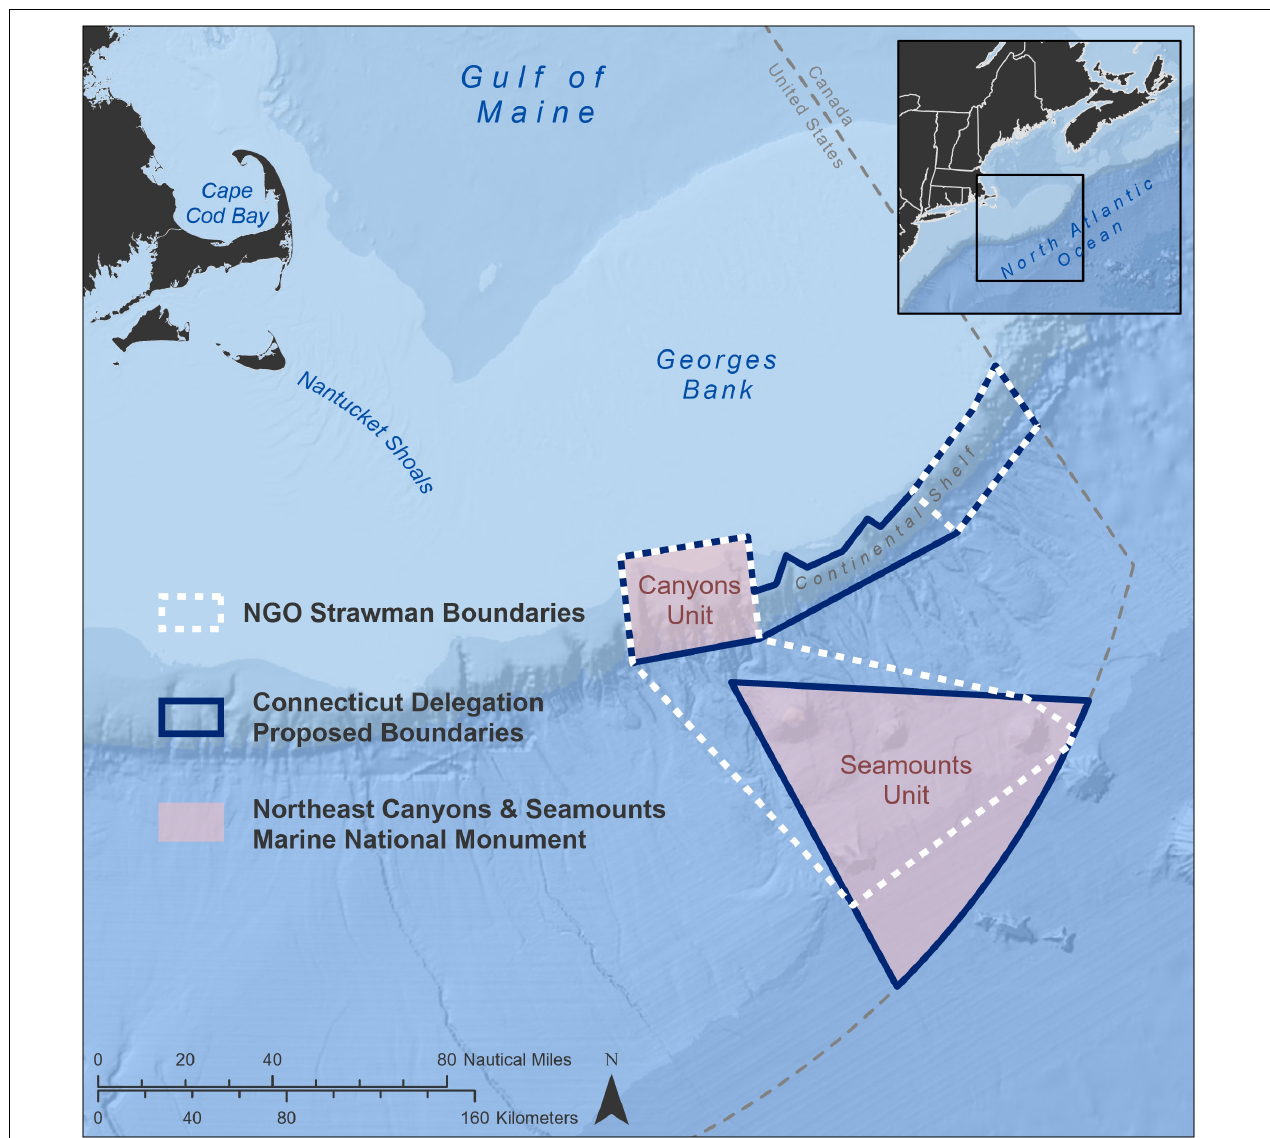
FIGURE 1 | Changes in boundaries from conception through final proclamation of the Marine National Monument. Areas delineated above include the initial boundaries proposed by a coalition of public aquaria and environmental groups (14,834 km 2 ), the request directly to President Obama by the Connecticut Congressional delegation (16,006 km 2 ), and the final area designated by President Obama under the authority of the Antiquities Act (12,696 km 2 ). The area in the final designation was significantly reduced in size from original requests as a response to fishing industry concerns and those of other